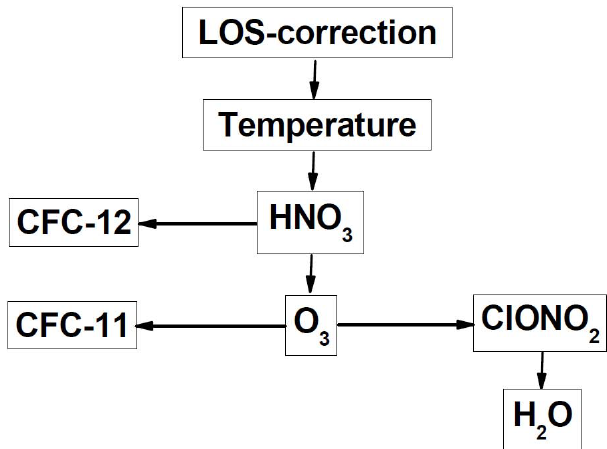
Fig. 10. Schematic representation of the subsequent retrievals of LOS correction, temperature and the discussed trace gases from MIPAS-STR channel 1 spectra. For each target parameter, all other parameters prior in the scheme are determined